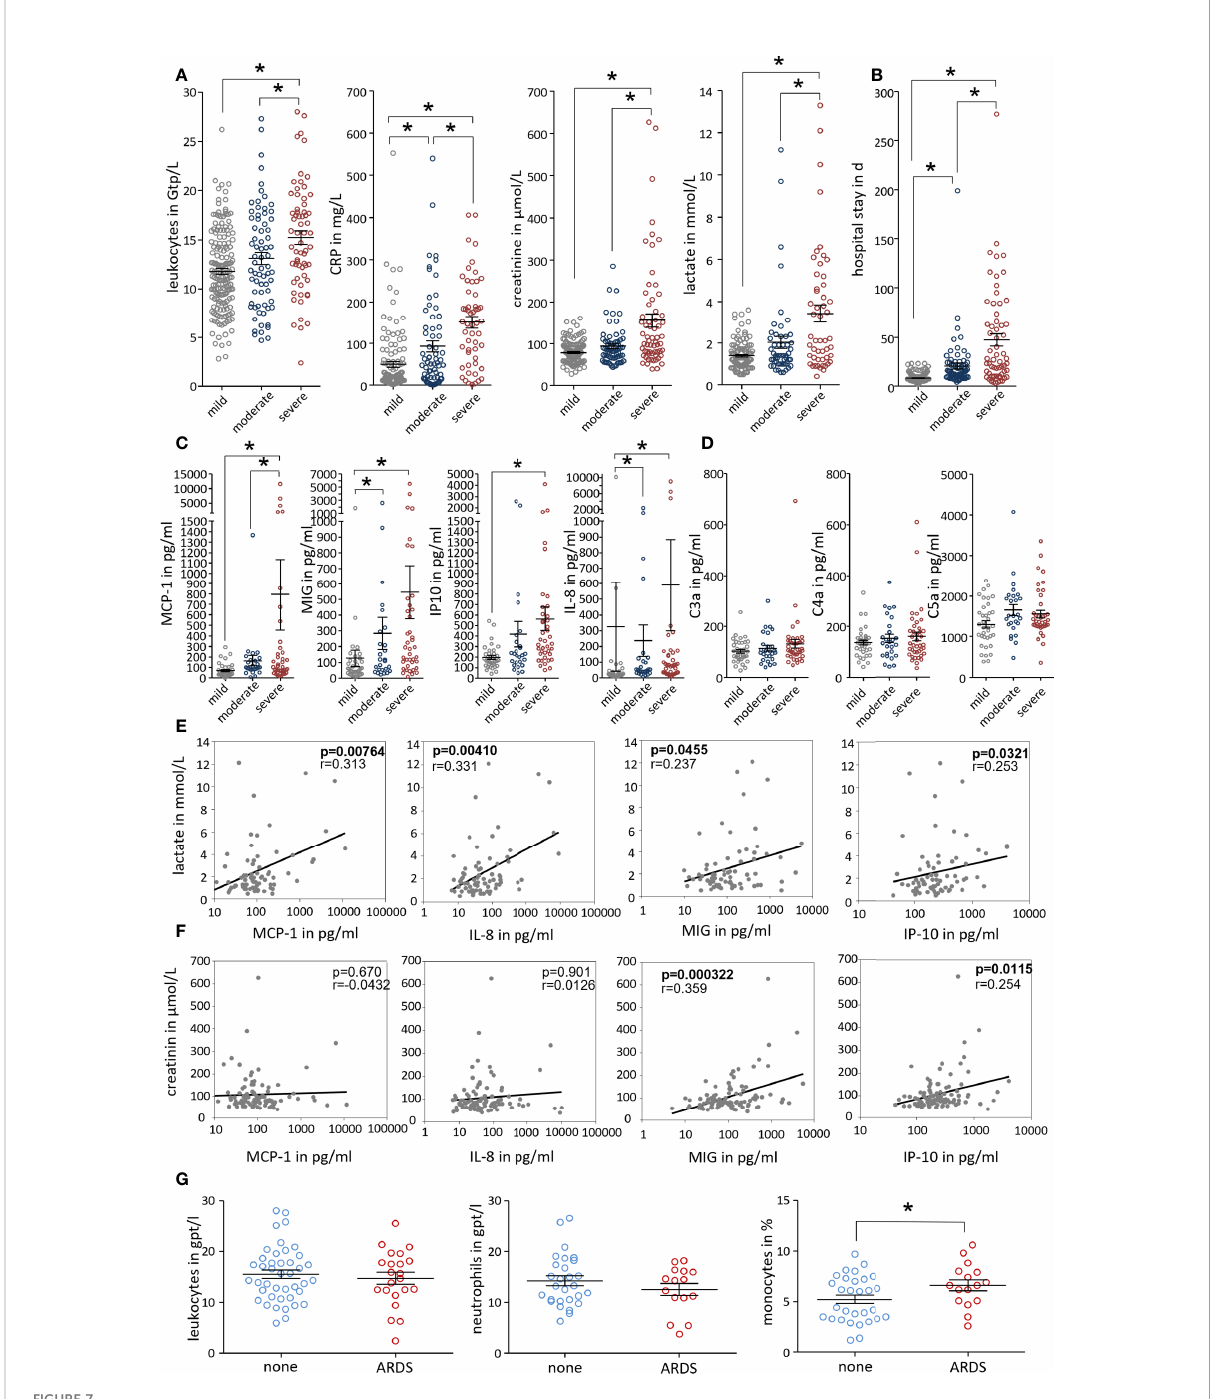
FIGURE 7 Disease severity correlates with serum monocyte attracting chemokines in patients. Patients were grouped based on the revised Atlanta classi fi cation. (A) Clinical parameters were evaluated from the day of admission. In fl ammatory markers (leukocytes count and C-reactive protein (CRP)), serum lactate and creatinine levels were signi fi cantly increased in SAP patients. (B) Severe disease is also re fl ected by a signi fi cantly prolonged hospital stay. (C, D) Serum chemokines and complement cleavage products were analysed in 104 AP patients. Chemokines, MCP-1, MIG, IP-10 and IL-8 were signi fi cantly increased in SAP, whereas complement factors C3a, C4a and C5a show no severity related increase. (E, F) Patients samples were analysed by Kruskal-Wallis test followed by Dunn ’ s multiple comparison test, signi fi cant differences were de fi ned by p<0.05 and marked by asterisk. Correlation analyses were performed for serum lactate and serum creatinine to test a possible relationship between serum chemokines and markers of organ dysfunction. A correlation was tested by spearman rank order correlation and p values are shown in each graph. (G) The comparison of the blood leukocyte counts in SAP patients showed that patients with ARDS have a signi fi cantly increased percentage of monocytes in the blood compared to patients without